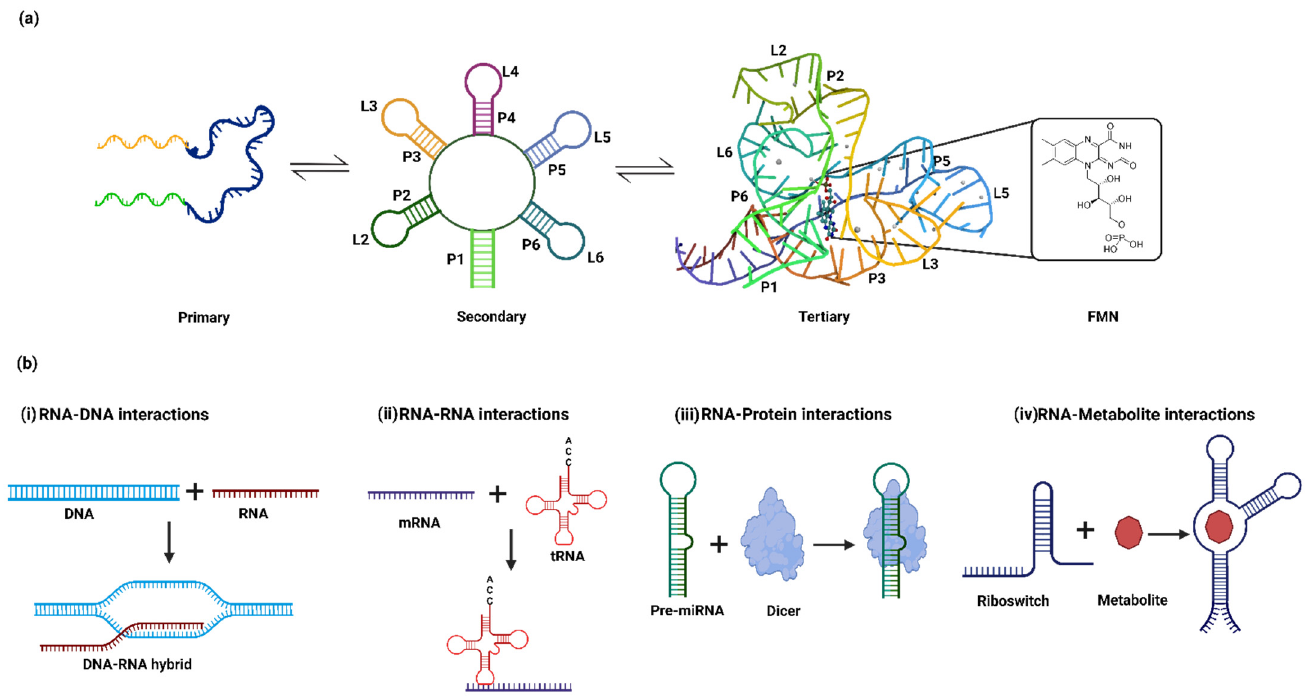
Figure 1. ( a ) The hierarchical folding of aptamers in a flavin mononucleotide (FMN) riboswitch. The primary structure of the FMN aptamers involves a single-stranded nucleotide sequence that sequentially folds into the secondary structure consisting of 6 stems (P1–P6) and 5 loops (L2–L6). The FMN binding pocket is formed in a tertiary structure via loop–loop (L2–L6 and L3–L5) and loop–helix (L6-P2 and L3-P5) interactions (PDB ID: 3F2Q). ( b ) Mode of action of regulatory RNA via interaction with (i) DNA (e.g., R-loop formation), (ii) other RNAs (tRNA riboswitch), (iii) proteins (e.g., dicer) and (iv) metabolites (e.g., FMN riboswitch).